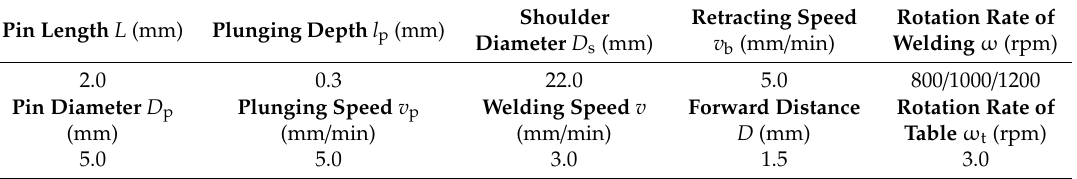
Figure 2. Drawing ( a ) and load-displacement curve ( b ) of tensile-shear specimen of dissimilar Al/steel keyhole-free FSSW joints.